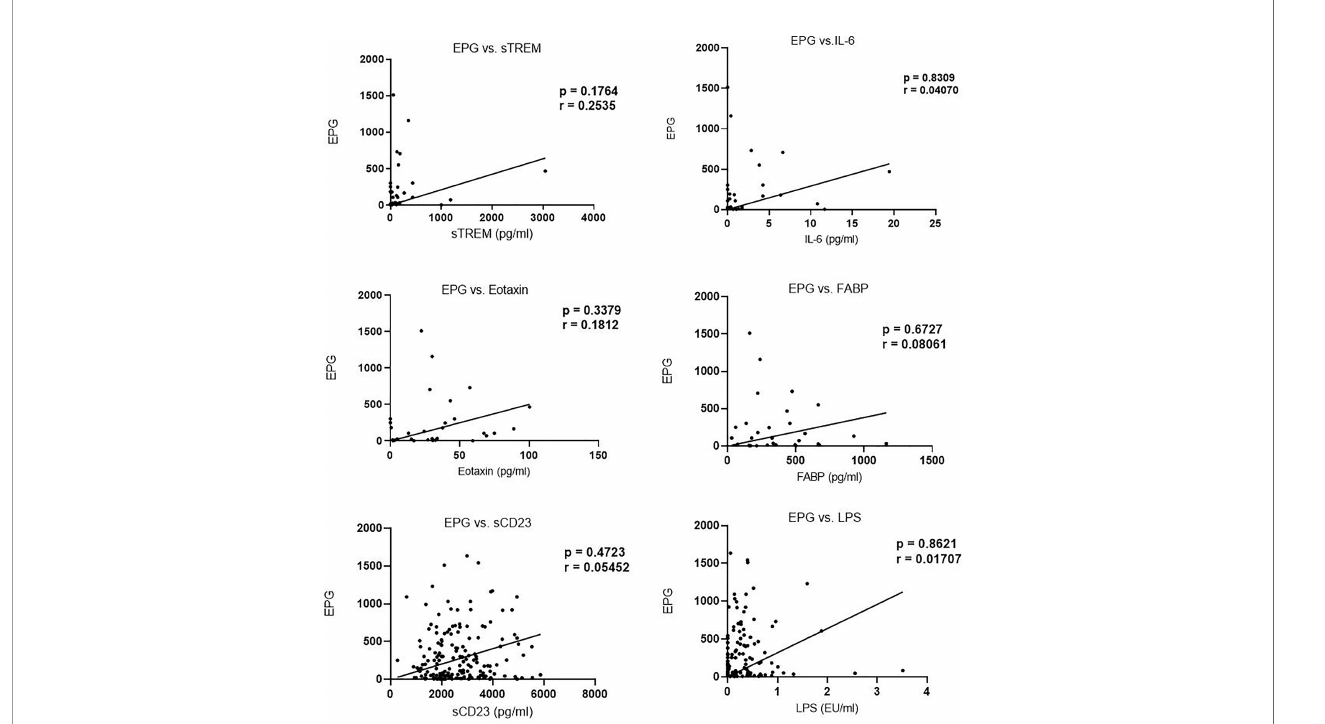
FIGURE 3 | Correlation between biomarker concentration and eggs per gram (EPG) among infected children.